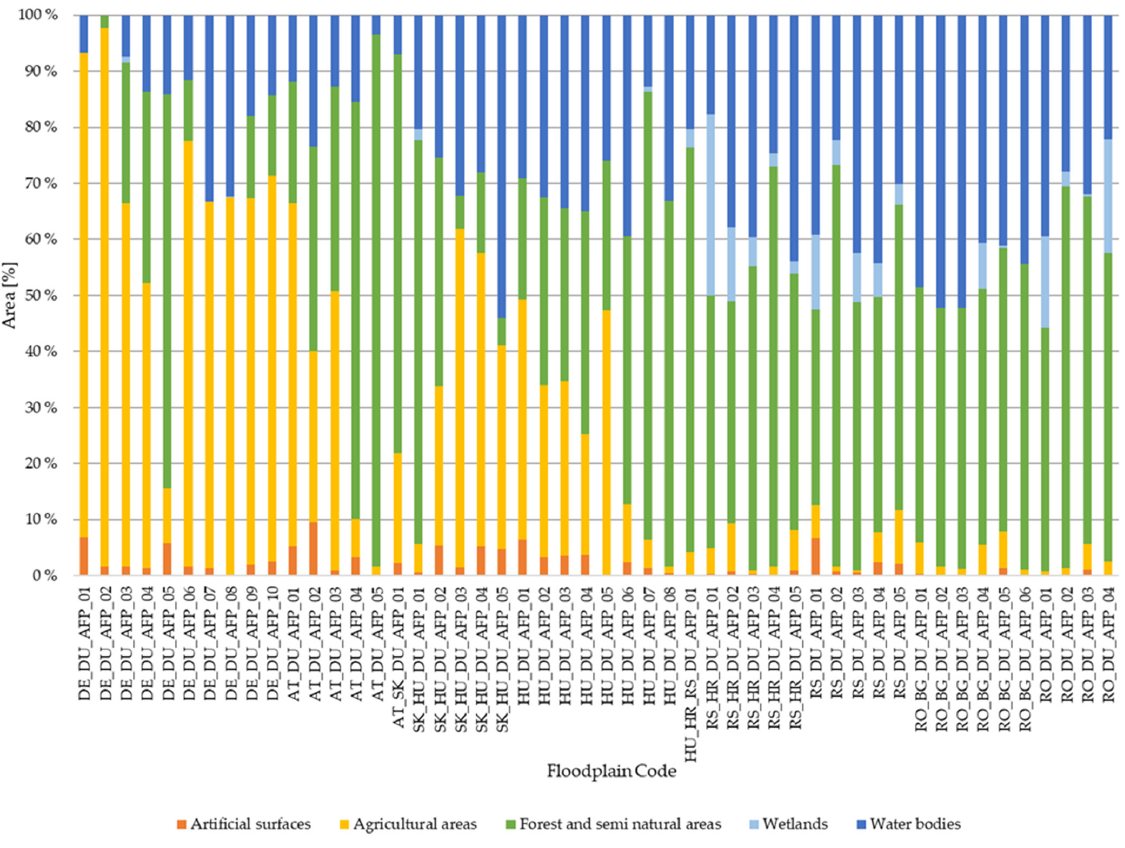
Figure 7. Distribution of land use classes, as percentages, for all active Danube floodplains from up- to downstream. Table 4. Comparison between active and former floodplain area for each country (incl. main river channel and excl. Delta).